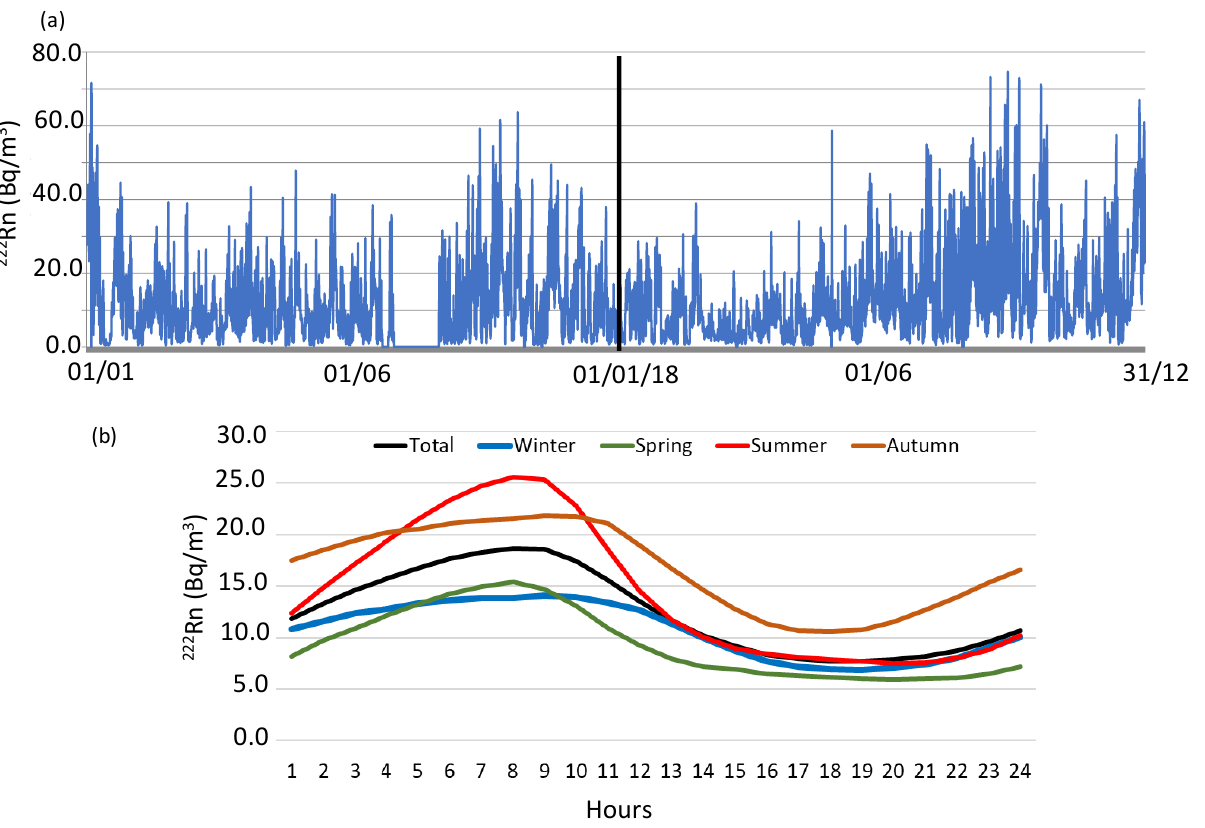
Figure 2. ( a ) Hourly 222 Rn concentration evolution and ( b ) diurnal composite of average hourly radon concentrations in Bilbao during the period 2017 – 2018.